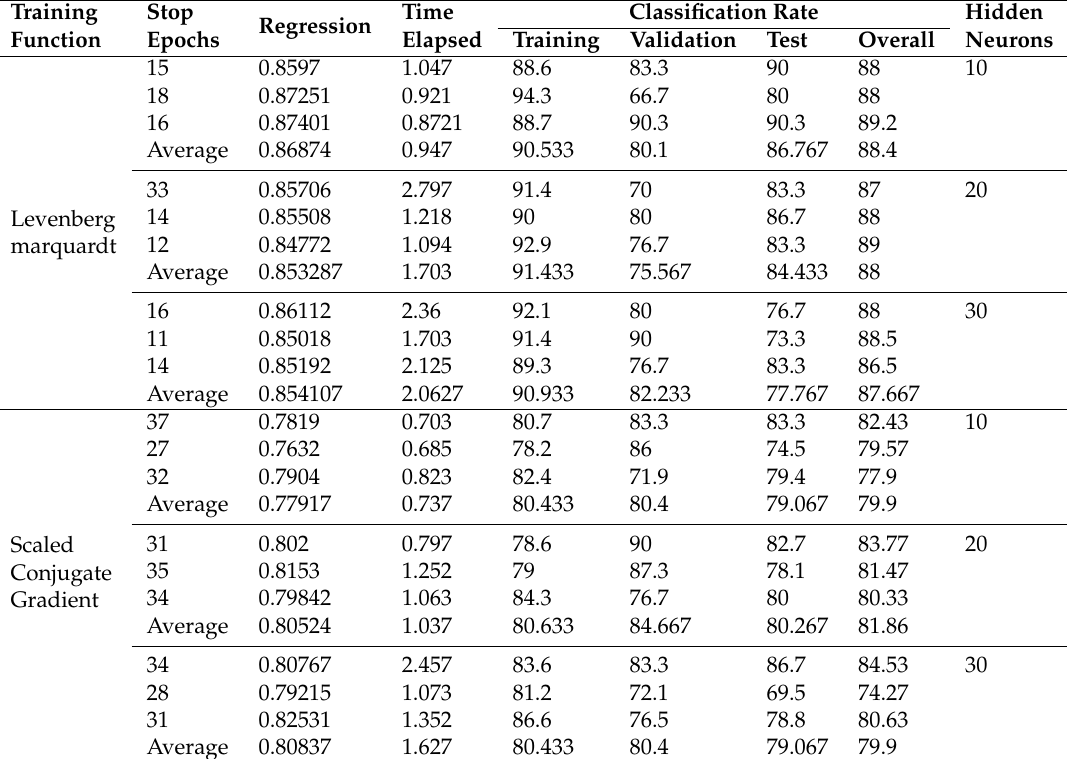
Table 6. The classification accuracy based on training functions